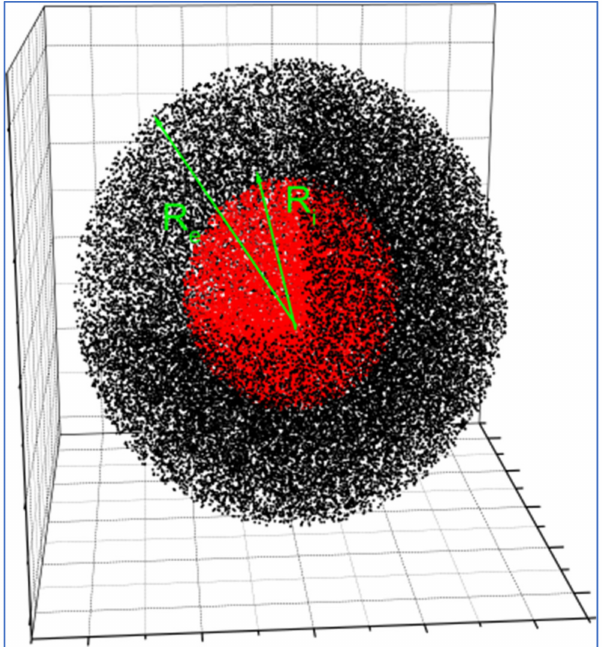
Figure 9. Distribution of sample of particles. R i and R e are the radius of the core and the total radius of the sphere, respectively. Colors of the dots represent the negative (red core) or positive (black shell) contrast corresponding to each